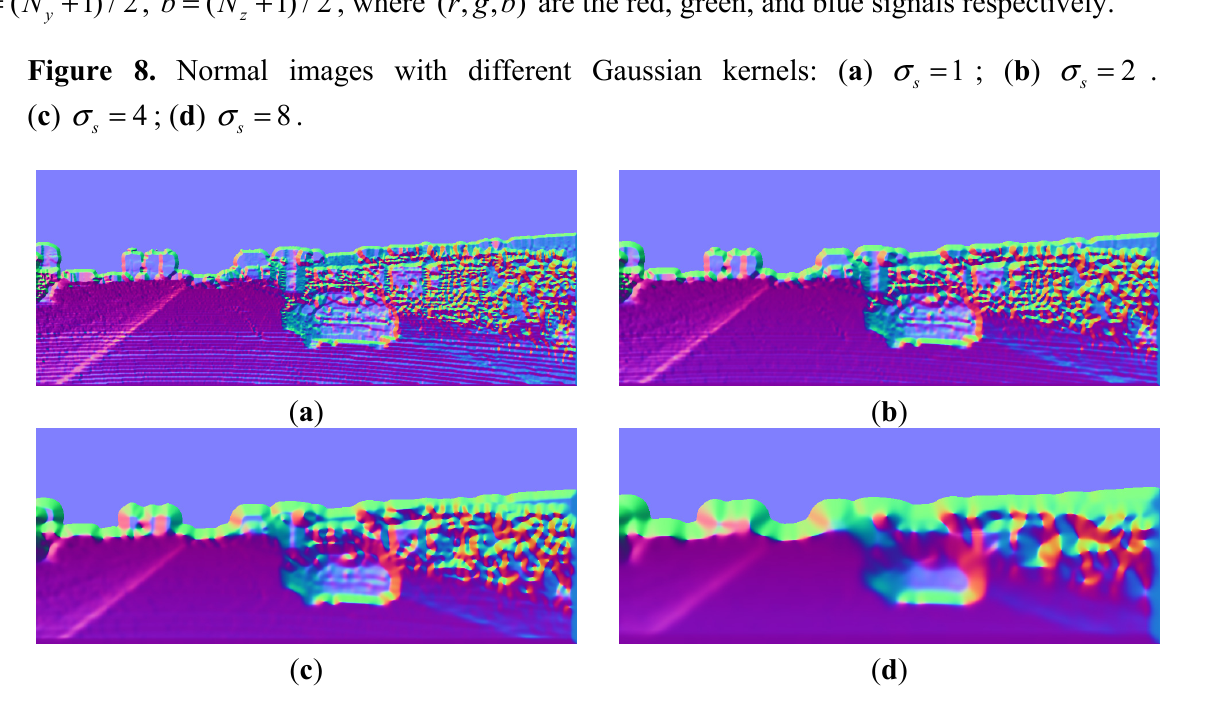
Figure 9. ( a ) Normal image; ( b ) Normal projection in Z